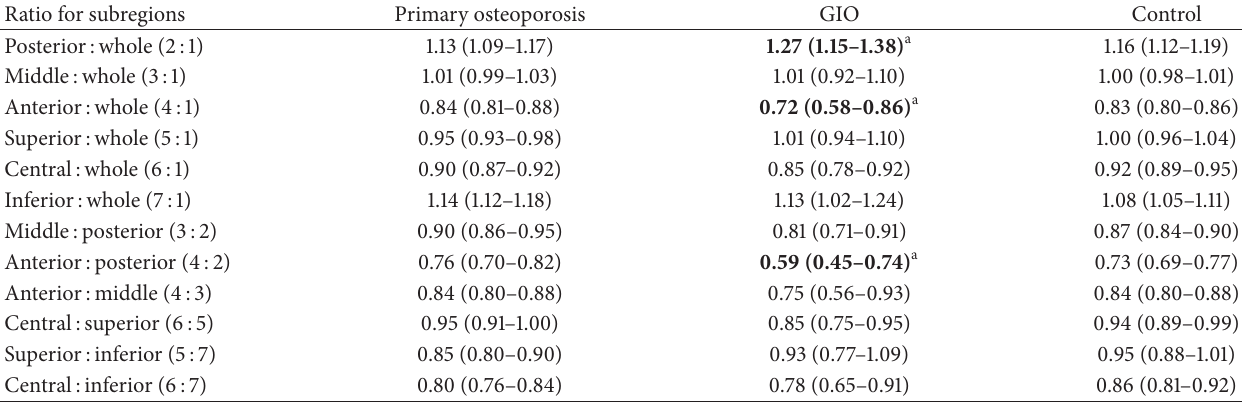
Table 2: Mean (95% CI) ratio values of srBMD for all